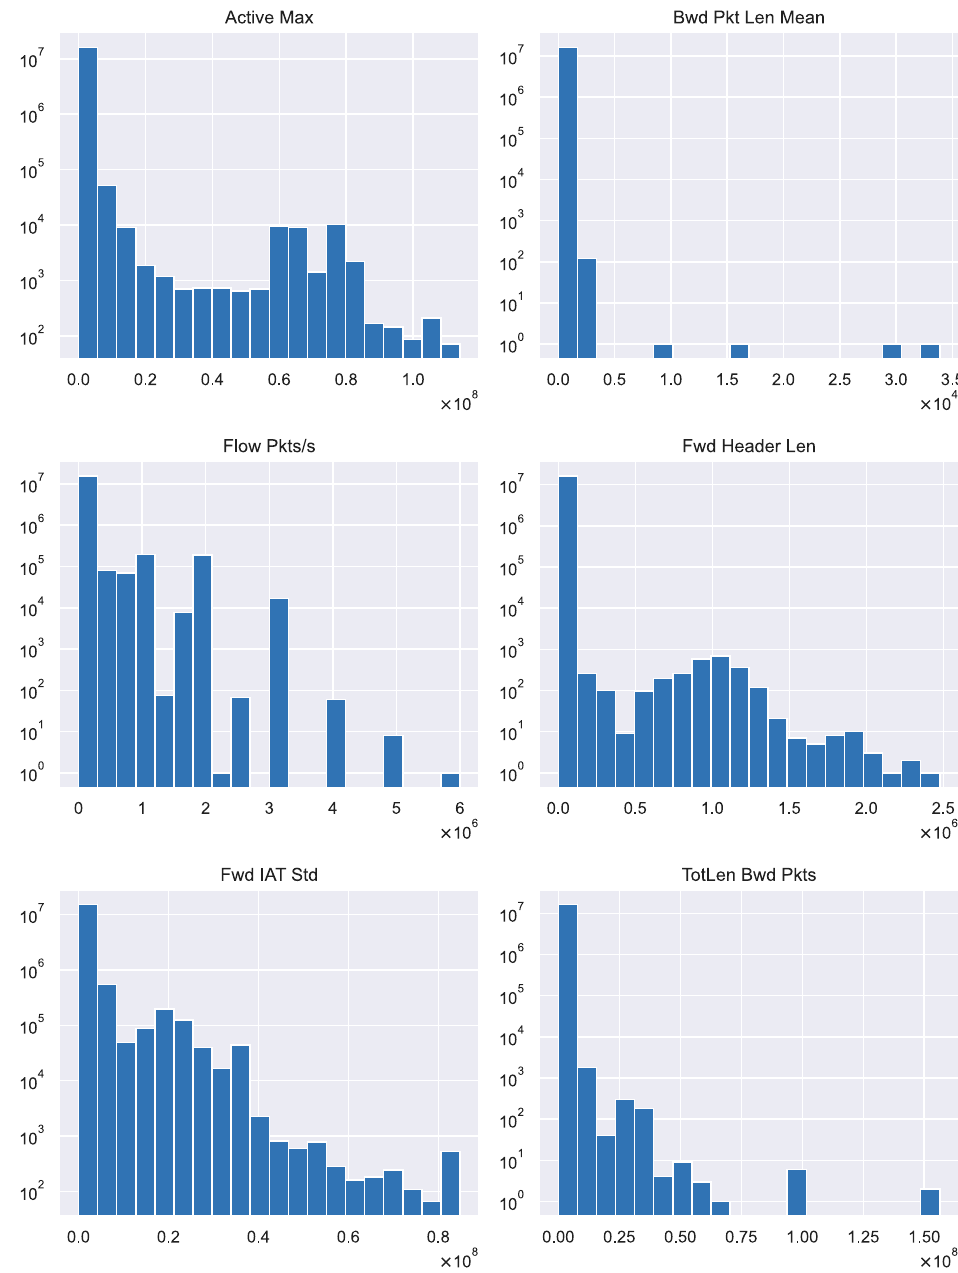
Figure 1. Histograms of selected numeric features in logarithmic scale for a complete